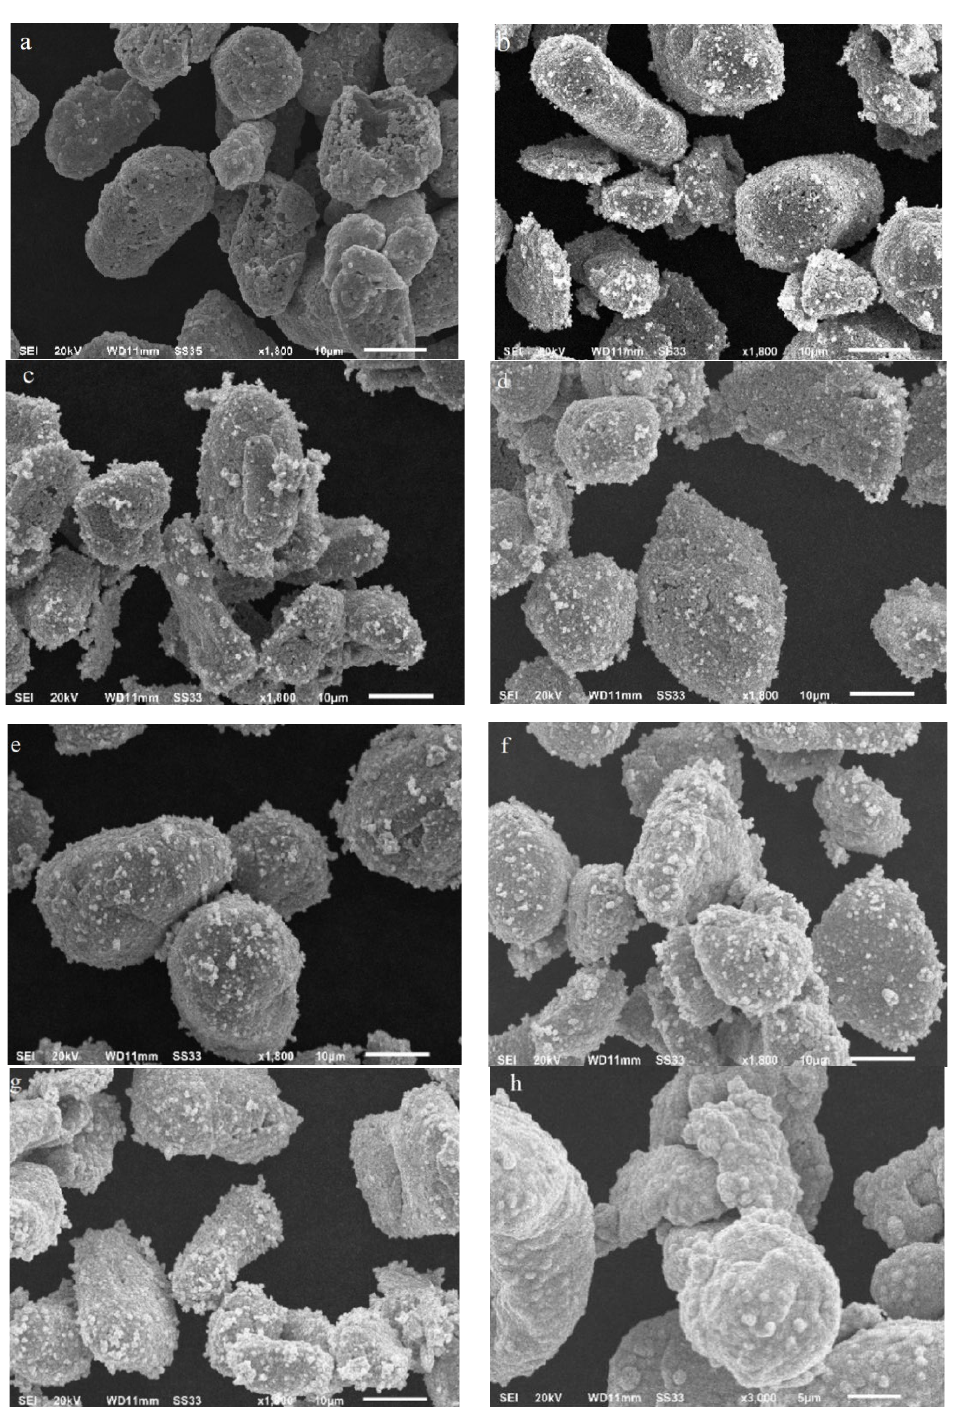
Figure 5. SEM images of the samples during the silver deposition process: ( a ) Surface morphology of E-Fill ™ 2707 Ni/C powder; ( b – h ) Surface morphology of the powders at different reaction time intervals: ( b ): 30min; ( c ): 60 min; ( d ): 90 min; ( e ): 120 min; ( f ): 150 min; ( g ):180 min; ( h ): 240 min.